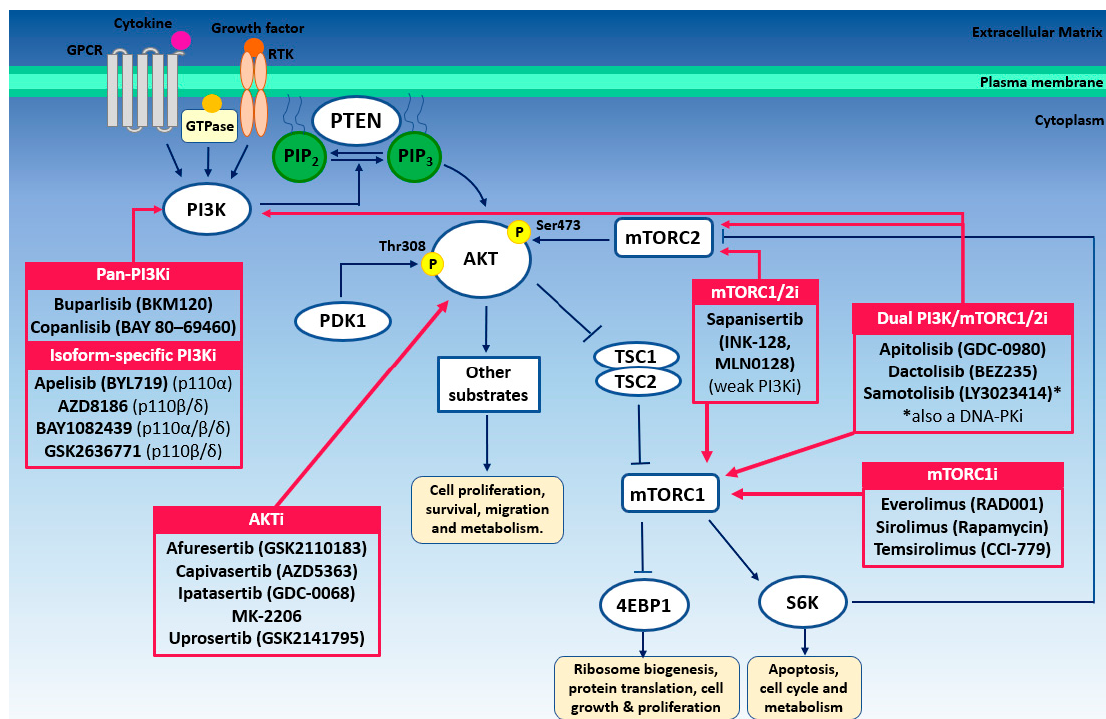
Figure 3. Targeting the PI3K–AKT–mTOR pathway to treat prostate cancer . Image shows small-molecule inhibitors that target key components of the PI3K–AKT–mTOR signaling pathway that have